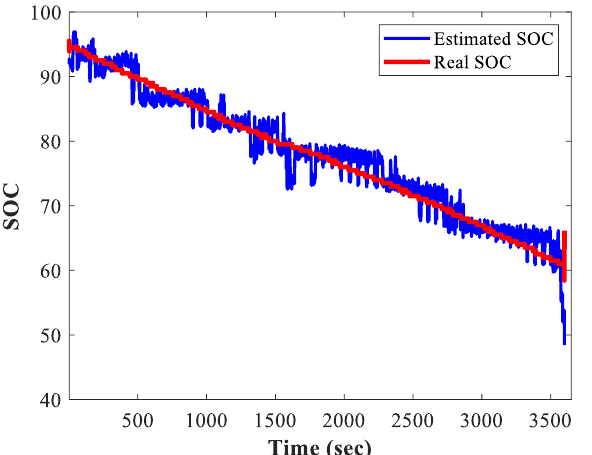
Figure 9. Visual representation of the SOC estimated by the proposed methodology (blue) and the real-time SOC measured during an experimental test (red).